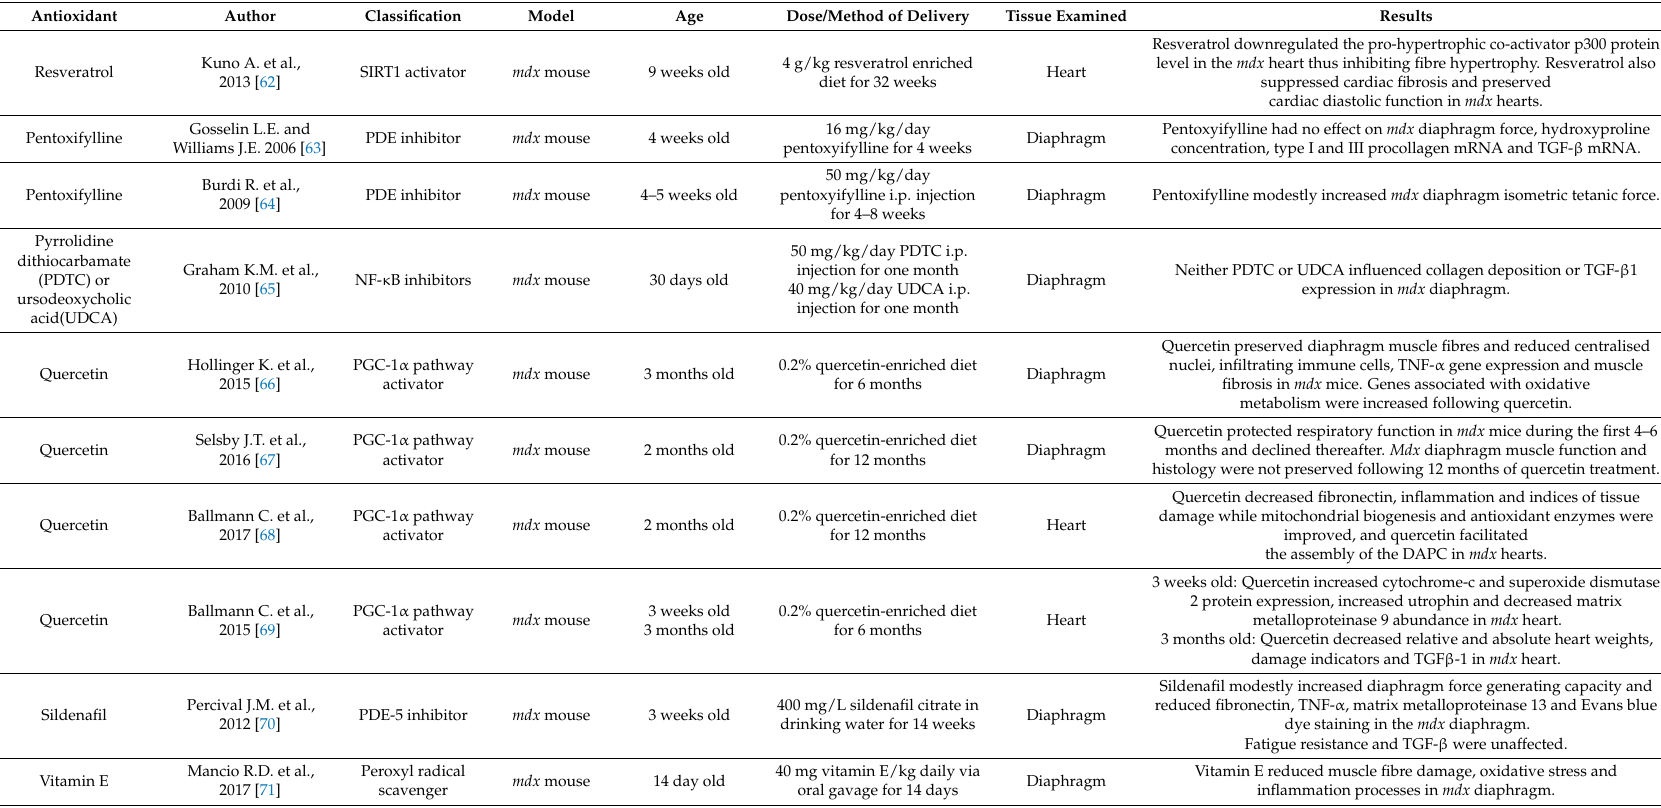
List of abbreviations: 4-HNE, 4-Hydroxynonenal; Ca 2+ , calcium; CD68, cluster of differentiation 68; CK, creatine kinase; DHE, dihydroethidium; EGCG, epigallocatechin-3-gallate; IL-1 β , interleukin-1 beta; i.p., intra-peritoneal; MMP, matrix metalloproteinase; NAC, N-acetylcysteine; NADPH, nicotinamide adenine dinucleotide phosphate-oxidase; NF κ B, nuclear factor lappa-light-chain-enhancer of activated B cells; PDE, phosphodiesterase; PDTC, pyrrolidine dithiocarbamate; PGC-1 α , peroxisome proliferator activated receptor gamma co-activator 1 alpha; ROS, reactive oxygen species; SR, sarcoplasmic reticulum; s.c., sub-cutaneous; SIRT-1, sirtuin-1;TGF- β 1, tumour growth factor beta 1; TNF- α , tumour necrosis factor alpha; UDCA, ursodeoxycholic